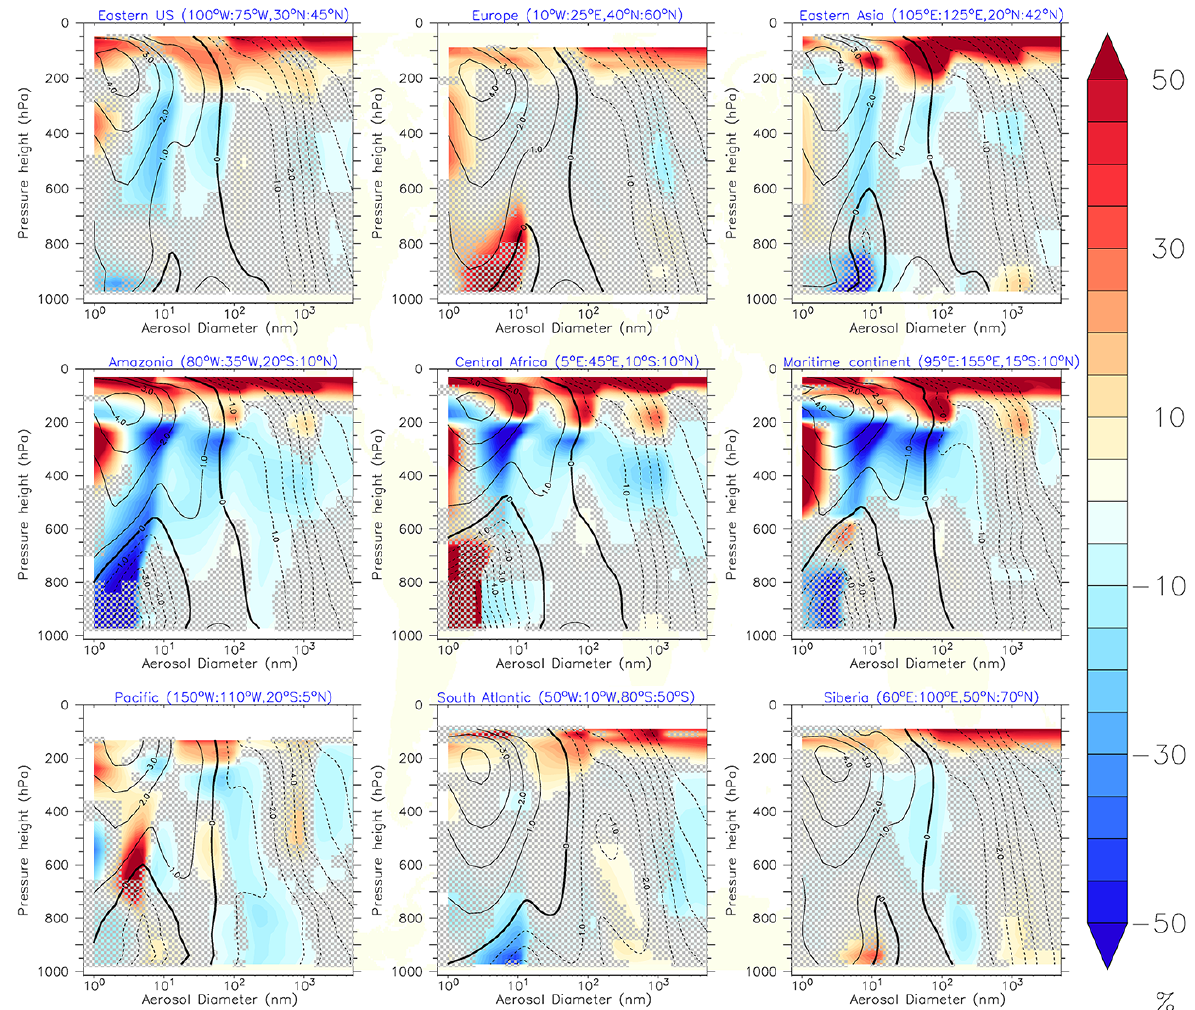
Figure 4. Nine-panel plot of the vertically resolved percentage differences (including LNO x emissions as the reference case, i.e. (NOLNOX- LNOX)/LNOX) in the aerosol size distributions as spatial and regional averages (for the respective regions). In each small frame the y axis depicts pressure altitude and the x axis the aerosol diameter from 1nm to 10µm. Overlayed are the contours of the absolute values of the size distributions, i.e. the absolute particle numbers calculated from overlaying the individual modes determined from the spatial and temporal mean in particlescm − 3 . The solid lines depict 1, 10, 100, 1000 particles, whereas the dashed lines represent 10 − 1 , 10 − 2 , etc. par- ticles. The figure depicts the present-day conditions. The respective regions are the central Pacific (150 ◦ W:110 ◦ W, 20 ◦ S:0),